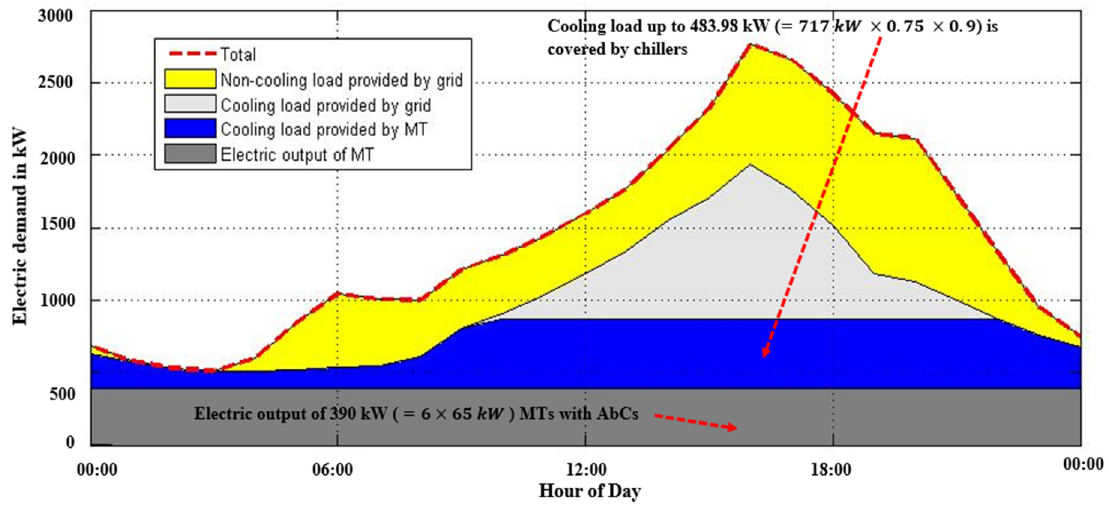
Figure 11. Electric output (full-blast power) and chilled air output (cooling demand) for Capstone MTs; 1 August 2013 (scenario